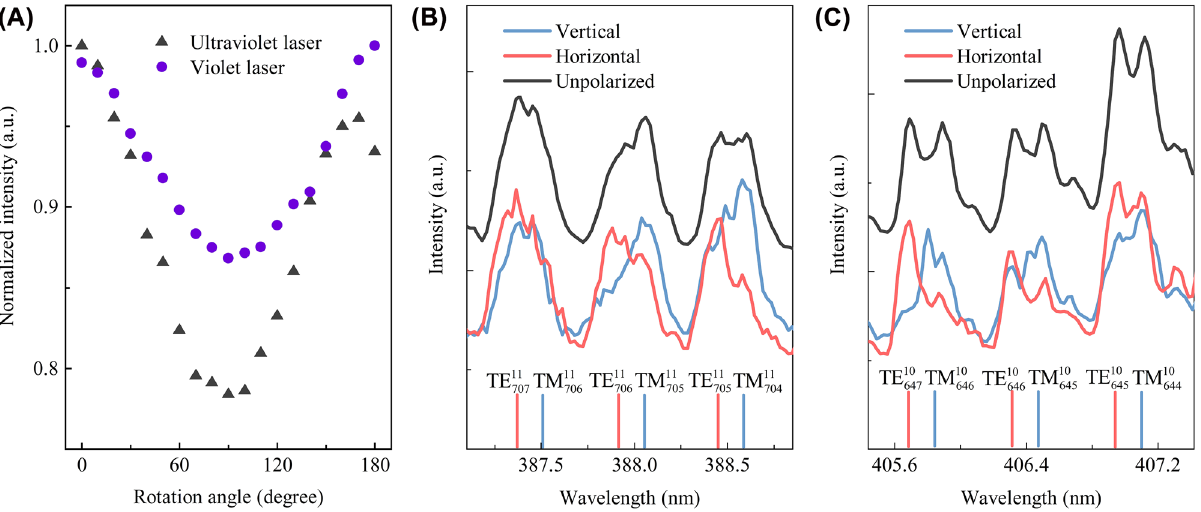
Figure 4: Laser polarizations. (A) Emission intensity as a function of the polarization degree. (B) and (C) Vertical, horizon polarized and unpolarized lasing spectra, with the calculated WGMs, where the superscript and the subscript represent the axial and azimuthal quantum numbers,